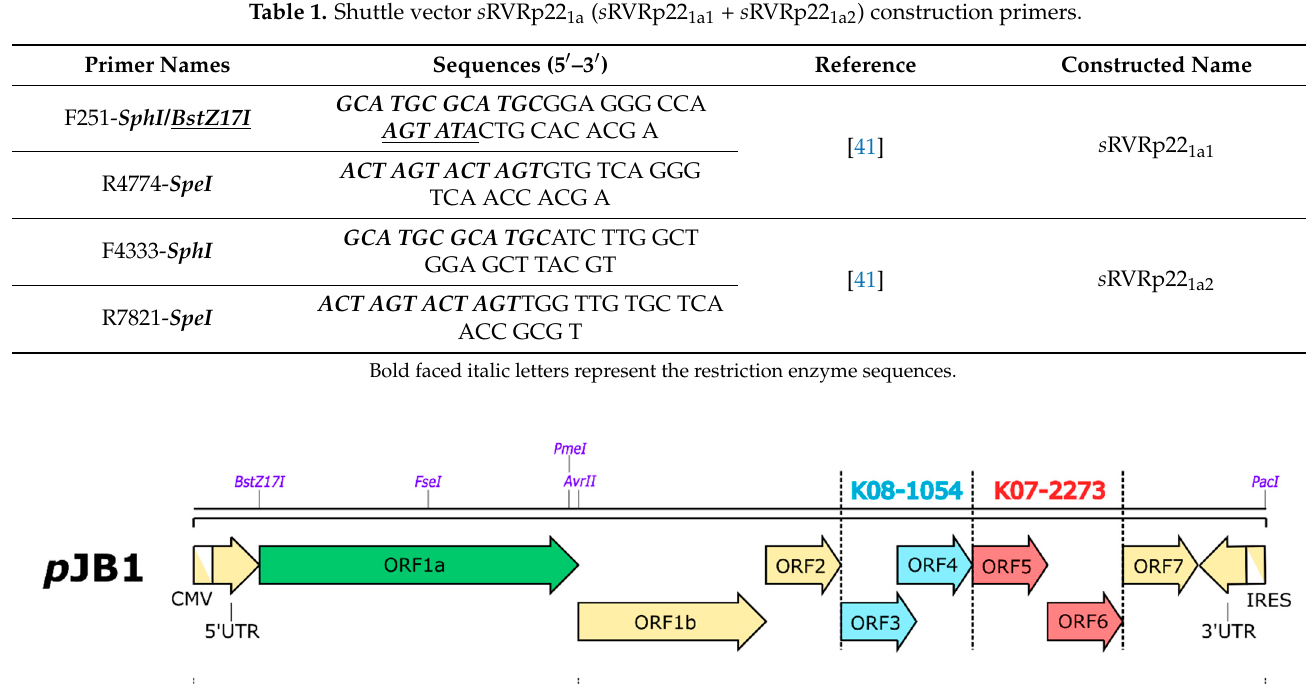
Table 1. Shuttle vector s RVRp22 1a ( s RVRp22 1a1 + s RVRp22 1a2 ) construction primers.